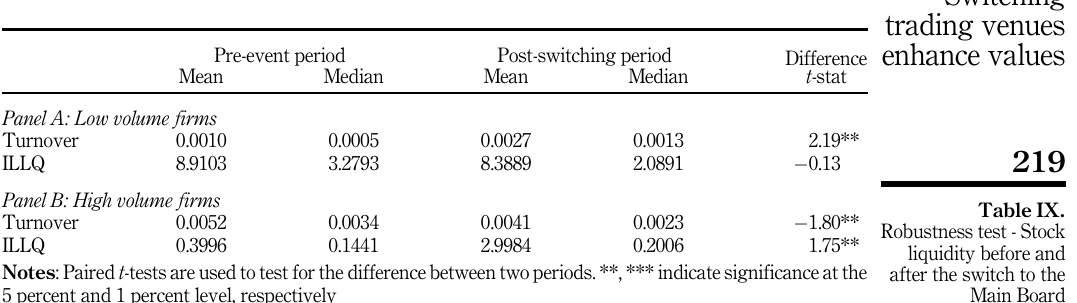
Figure 4. Robustness test. The